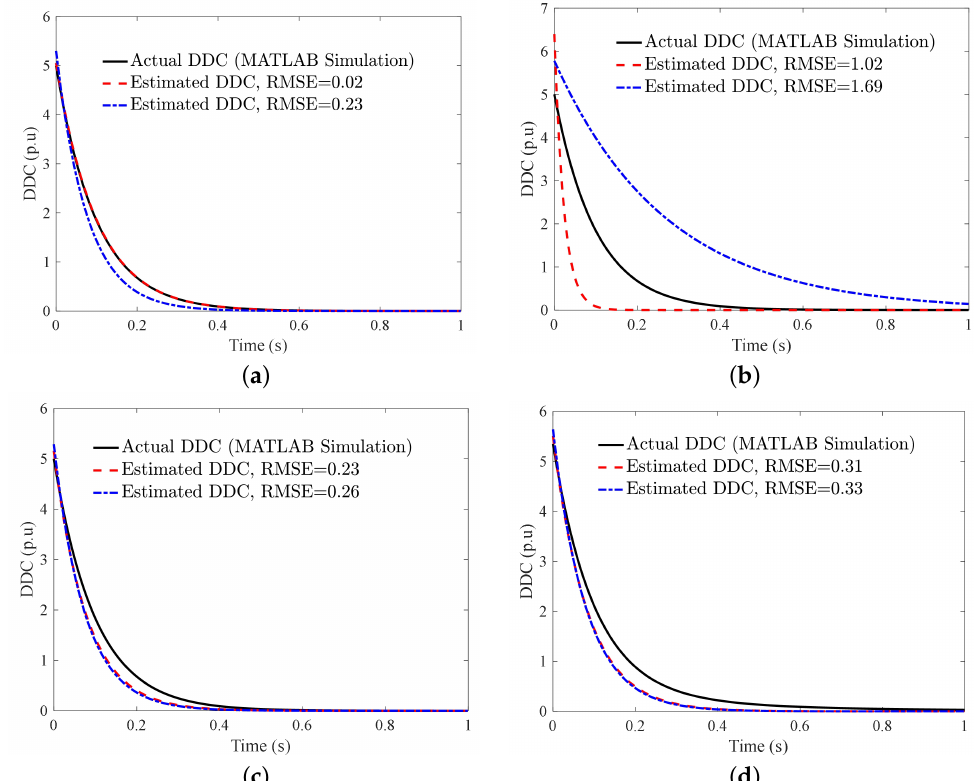
Figure 12. simulation results, method [18] (red line) and [3] (blue line), under four different cases: ( a ) without noise, ( b ) in the presence of noise, ( c ) 0.5 Hz frequency deviation,( d ) in the presence of the second